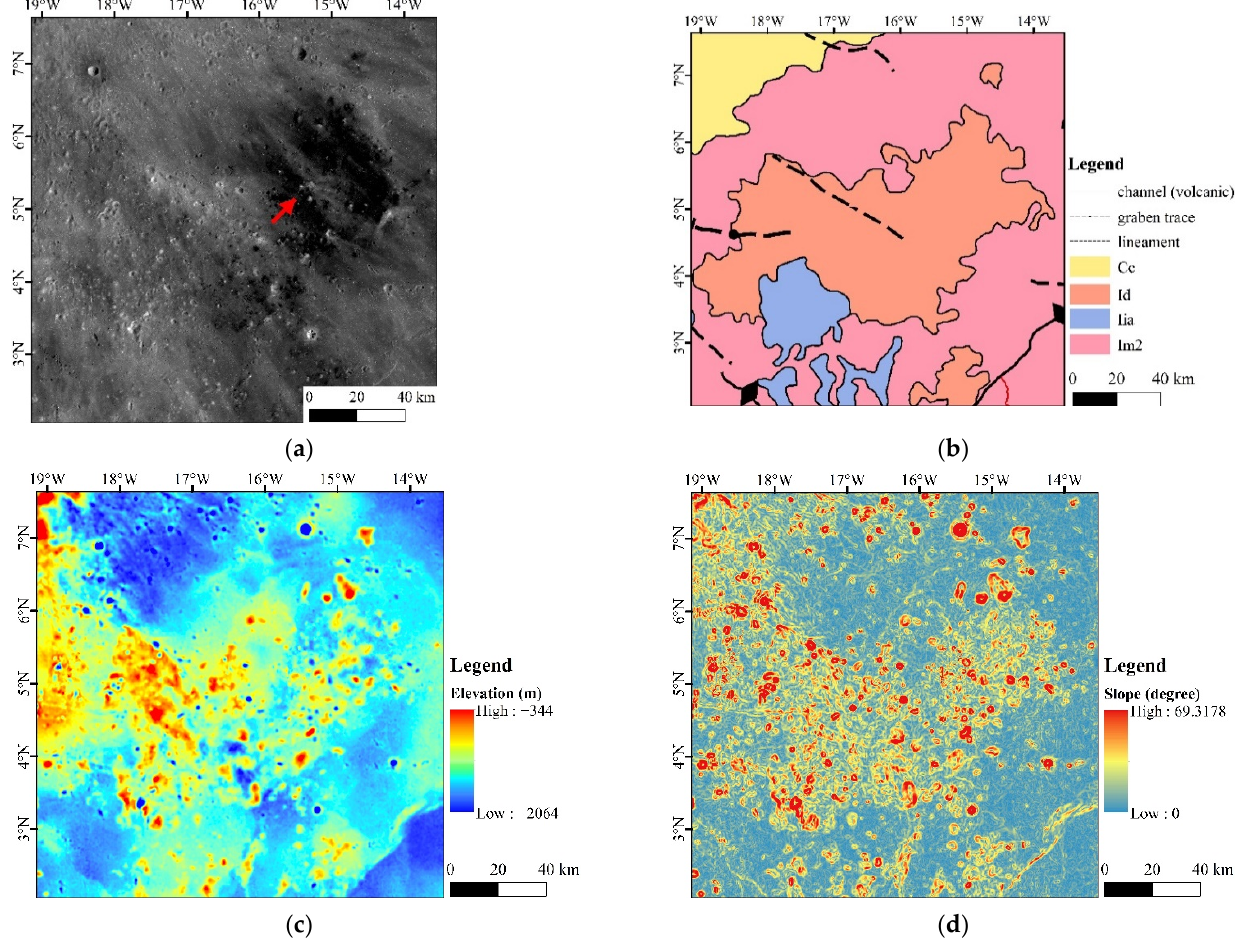
Figure 13. Sinus Aestuum-I DMD. ( a ) Sinus Aestuum-I DMD on the Kaguya TCortho Mosaic, the red arrow points to the radial texture from Copernicus; ( b ) Geological map of the Sinus Aestuum-I DMD; ( c ) Elevation of the Sinus Aestuum-I DMD; ( d ) Slope of the Sinus Aestuum-I DMD. Weitz et al. showed that the Sinus Aestuum-I DMD shares a centralized vent with the Sinus Aestuum-II DMD (Figure 14). The central vent would be at 4°N 12°W [48]. How- ever, the DMD at this location and other lowlands became buried by Im. Such a case and the OMAT map together, indicate that the Hawaiian-style eruption which formed the Si- nus Aestuum-I DMD and the Sinus Aestuum-II DMD is earlier than Im.